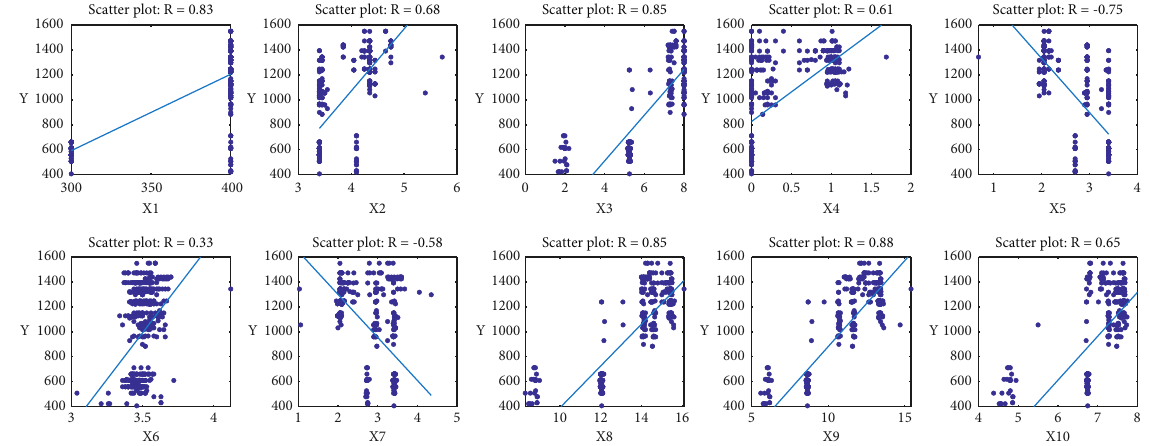
Figure 4: Scatter plots of the input variable ( X ) and pile bearing capacity ( Y